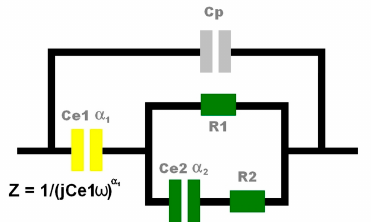
Figure 2. The equivalent circuit model of the electrode (yellow) and biological medium (green). Z is the expression of the impedance of a CPE element.